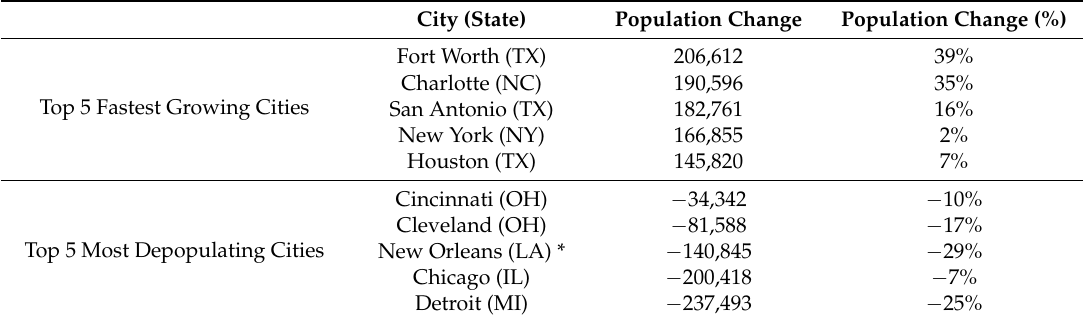
Table 1. The fastest- and slowest-growing cities by population growth between 2000 and